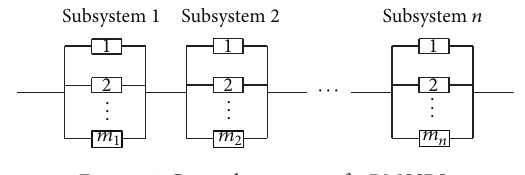
Figure 1: General structure of a RMSSPS.